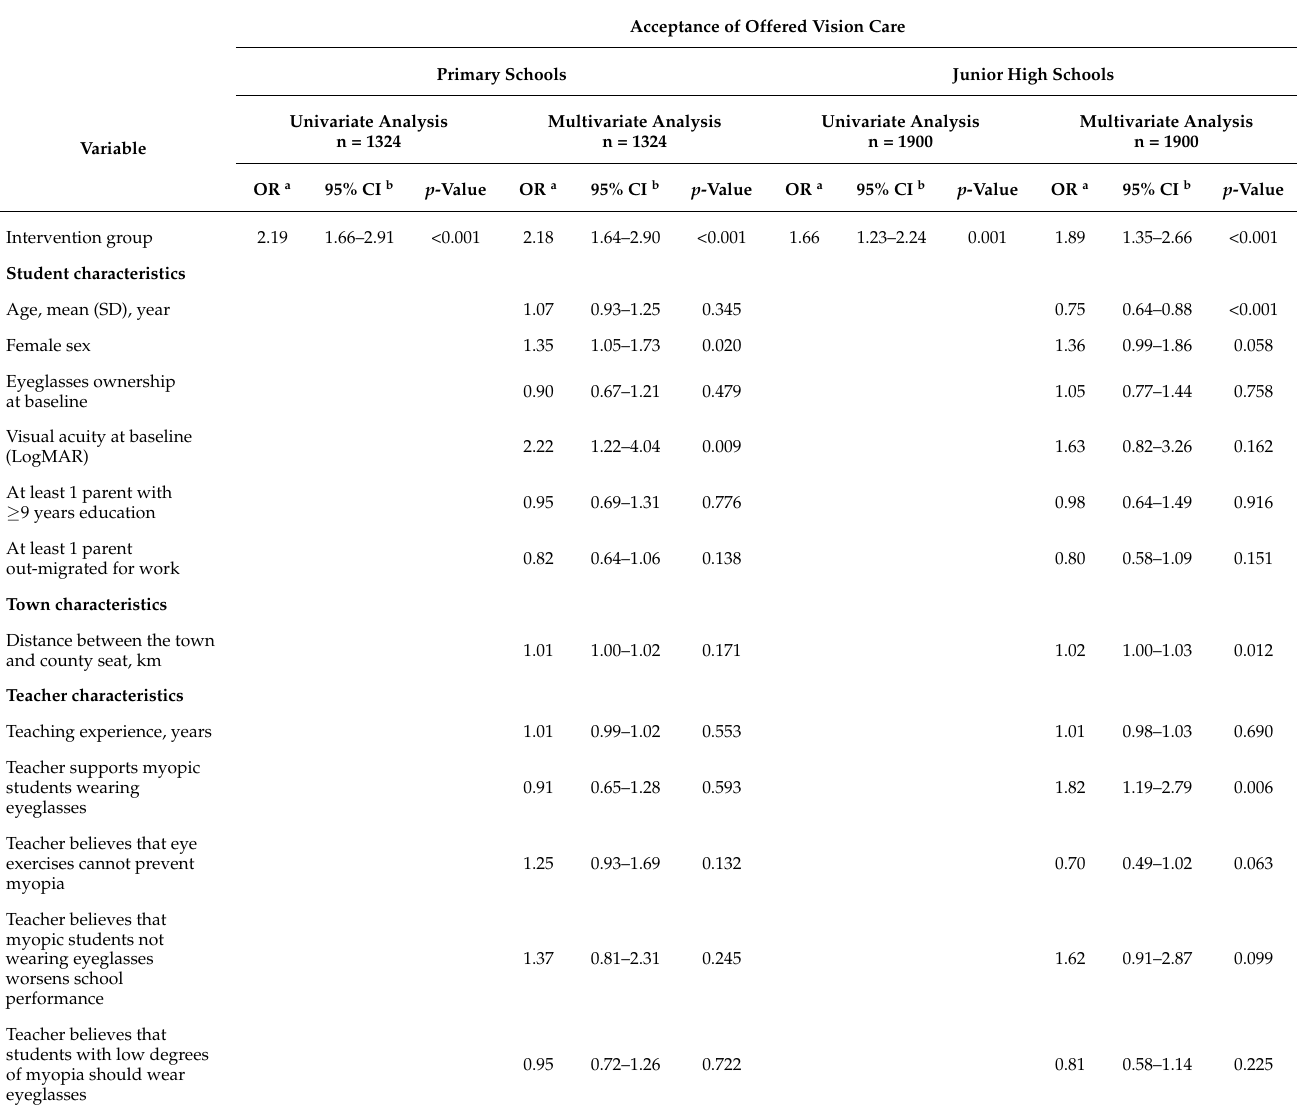
Table 4. Logistic regression analysis of the impact of providing teacher incentives on students’ acceptance of offered vision care between primary and junior high school